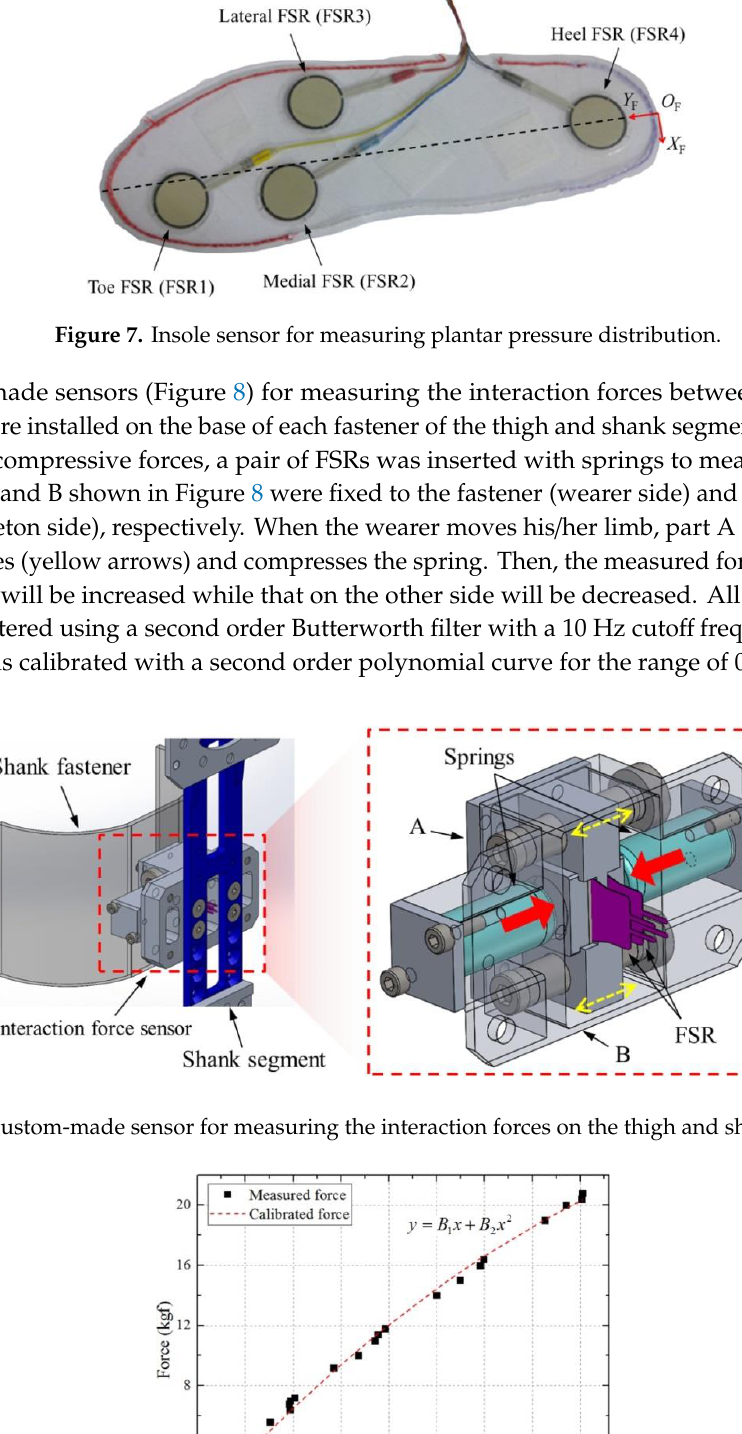
Figure 9. Calibration curve of the FSR in the range of 0 to 20 kgf. The ADC values divided by 1000 were fitted with a second order polynomial. The coefficients of this curve, B 1 and B 2 , are 6.97 and -0.47, respectively.